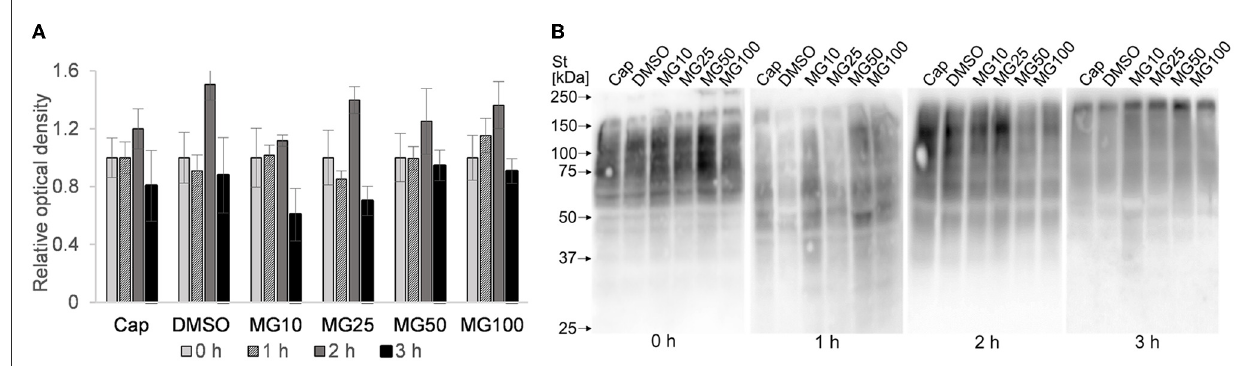
FIGURE7 Assessment of total ubiquitination in sperm protein extracts during sperm in vitro capacitation (IVC) under proteasomal inhibition at various concentrations of MG-132 (10, 25, 50, and 100 µ M) including capacitating (Cap) and vehicle (DMSO) controls. (A) The graph represents total ubiquitinated proteins determined by densitometric analysis. Data are presented as mean ± SEM. No significant differences were observed. (B) Representative Western blot detection of ubiquitinated proteins; n =